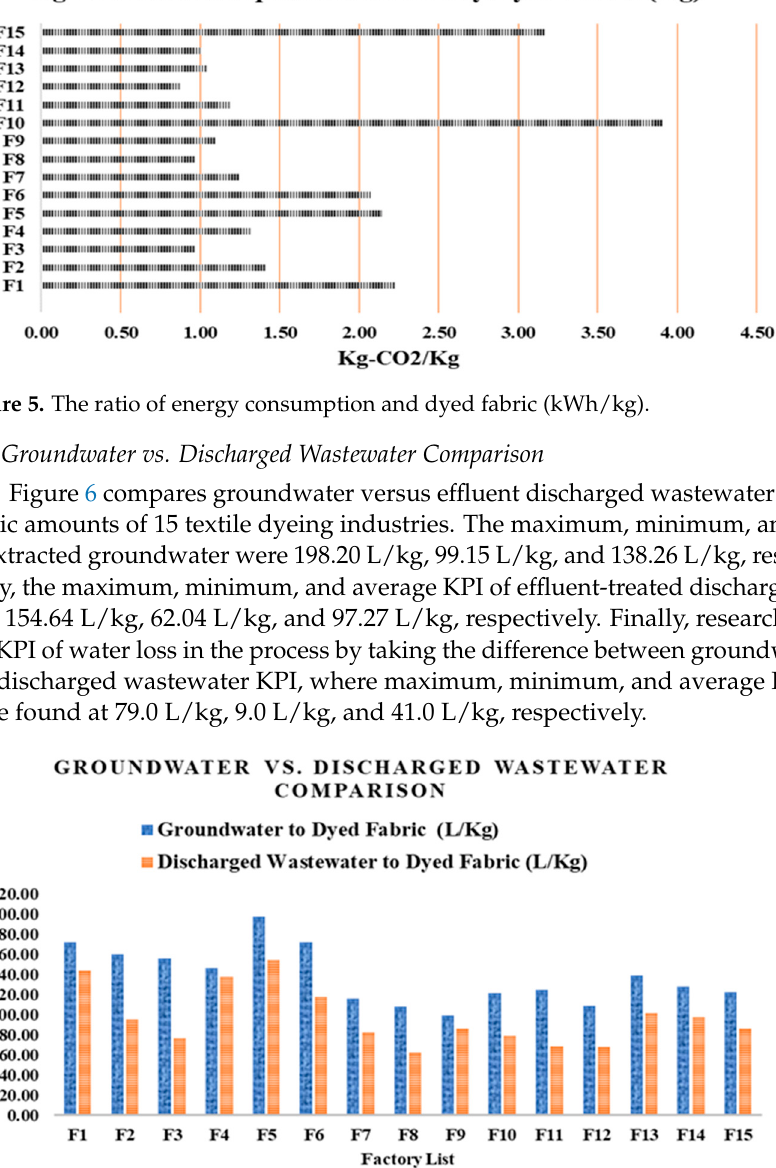
Figure 4. The ratio of energy consumption and dyed fabric (kWh/kg).